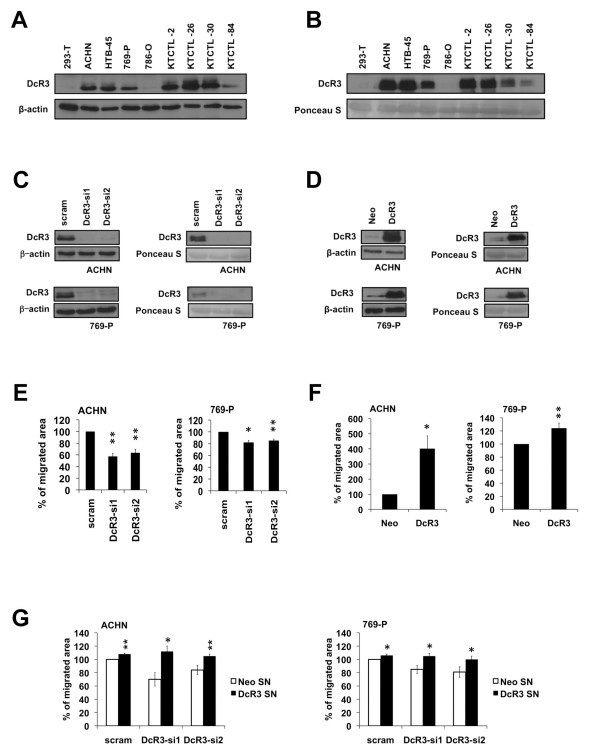
DcR3 promotes cellular migration in RCC. (A) Immunoblot analysis of whole-cell lysates showing DcR3 protein levels in different human RCC cell lines and human embryonic kidney 293-T cells. (B) Immunoblot analysis of precipitated protein from supernatant showing DcR3 protein secretion in different human RCC cell lines and human embryonic kidney 293-T cells. Ponceau staining is used to demonstrate equal protein loading. (C,D) Immunoblot analysis of whole-cell lysates (left) and precipitated protein from supernatant (right) of ACHN and 769-P cells transfected with two different DcR3-specific siRNAs or a non-specific siRNA (scram) (C) or stably overexpressing DcR3 or an empty control vector (neo) (D). (E) Scratch motility assay of ACHN and 769-P cells transfected with two different DcR3-specific siRNAs or a non-specific siRNA (scram). Bars indicate the percentage of cell migration in relation to cells transfected with a non-specific siRNA after 24 h (mean ± SEM; n=3; *p<0.05, **p<0.01; T-test). Representative images are shown in Additional file 1: Figure S1D. (F) Scratch motility assay of ACHN and 769-P cells stably overexpressing DcR3 or an empty control vector (neo). Migration was measured over a time course of 12 h (ACHN) or 24 h (769-P). Bars indicate the percentage of cell migration in relation to cells stably transfected with an empty control vector (mean ± SEM; n=3; *p<0.05, **p<0.01, T-test). Representative images are shown in Additional file 1: Figure S1E. (G) Scratch motility assay of ACHN and 769-P cells transfected with two different DcR3-specific siRNAs or a non-specific siRNA (scram) and incubated with either DcR3-containing or control supernatant (SN) of stable transfectants. Migration was measured over a time course of 24 h. Bars indicate the percentage of cell migration in relation to cells transfected with a non–specific siRNA and treated with control supernatant (mean ± SEM; n=3; *p<0.05, **p<0.01; T-test).